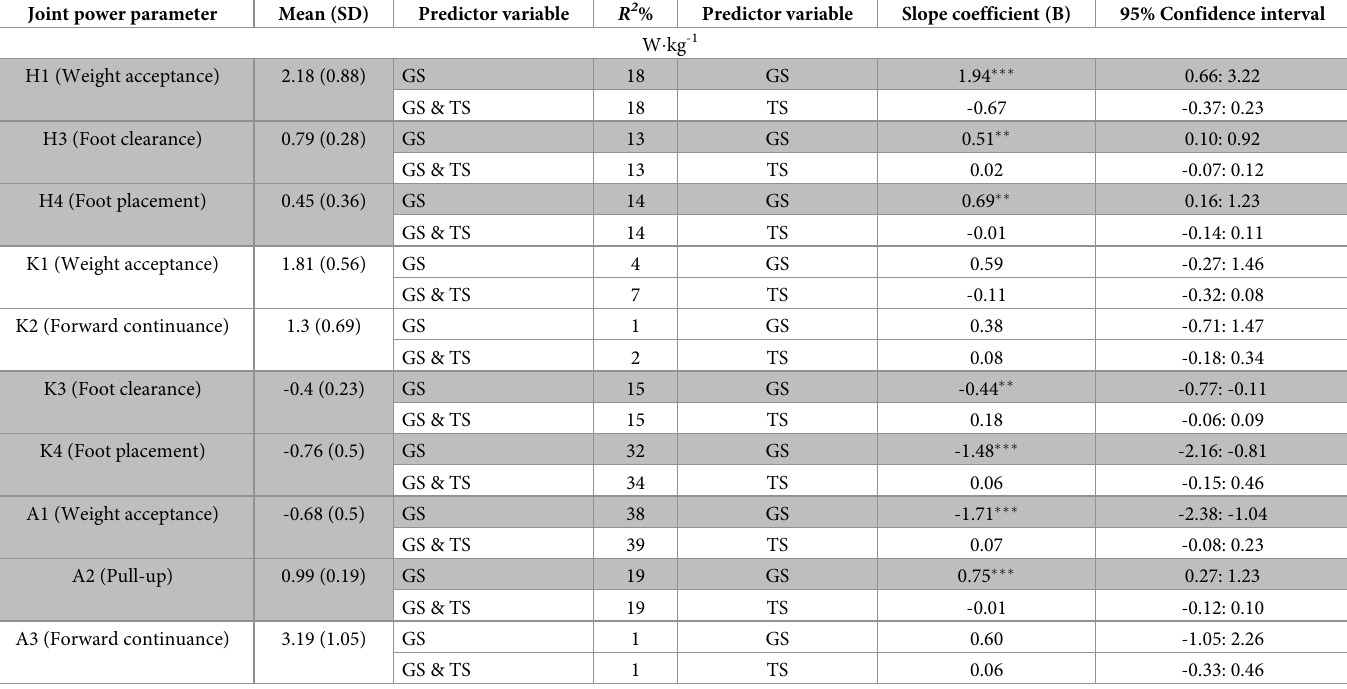
Table 4. Explained variance ( R 2 ) and slope coefficient for peak joint powers during stair ascent. Joint power